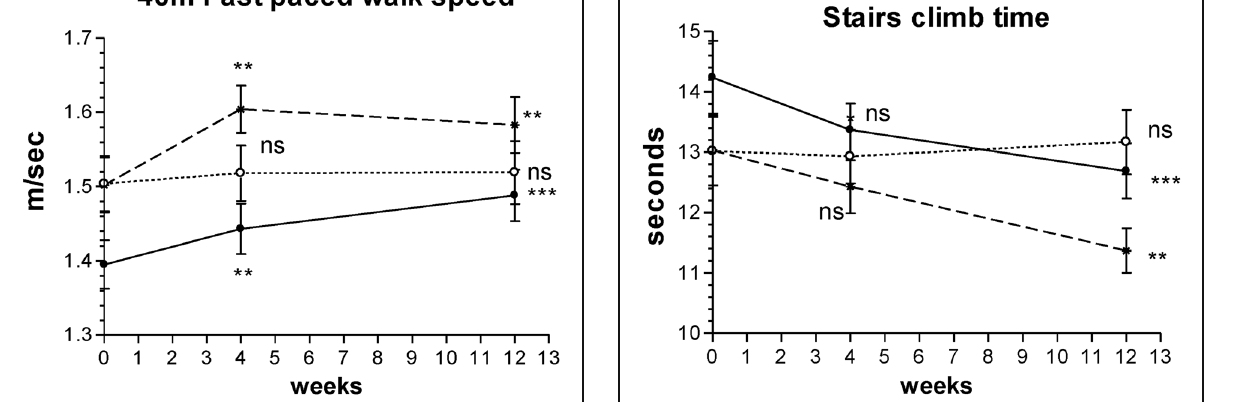
Fig. 5 The changes with time in the time required to ascend and descend a flight of stairs at weeks 0, 4, and 12 in the Curamin, CuraMed and placebo treatment groups. Within-group improvements (* p <0.05, ** p <0.01, *** p <0.001) in physical performance tests at the end of the study (visit 3) compared to baseline (week